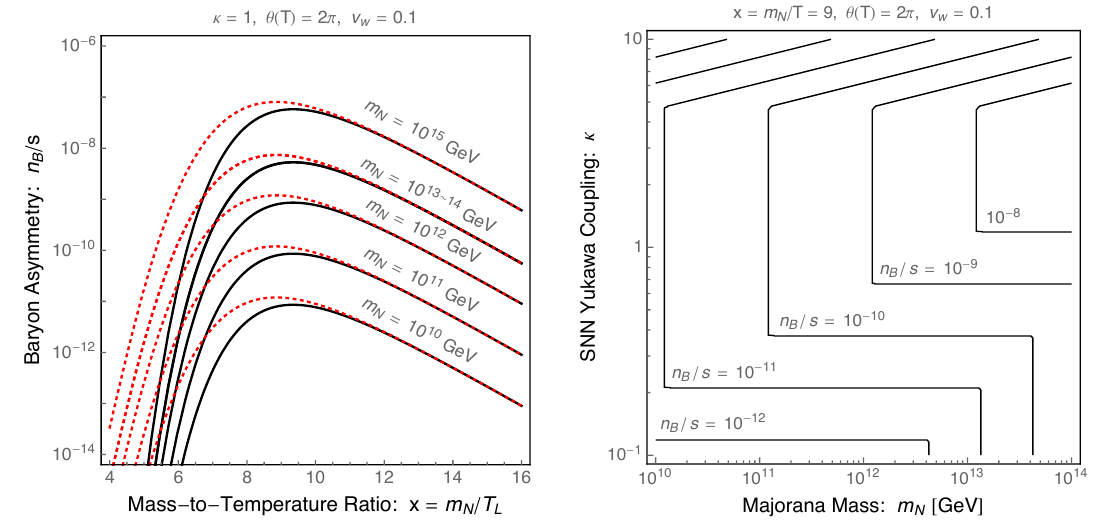
Figure 3 . Left: the baryon-to-entropy ratio n B =s , expressed as a function of the phase transition temperature T L and the Majorana neutrino mass m N . For the black curves we use the exact washout factor from eq. (2.18), and for the red (dashed) curves we use the approximation from eq. (2.20), which appears in the expression for n B =s from eq. (2.23). Right: variation of n B =s over the parameter space with x = m N =T = 9